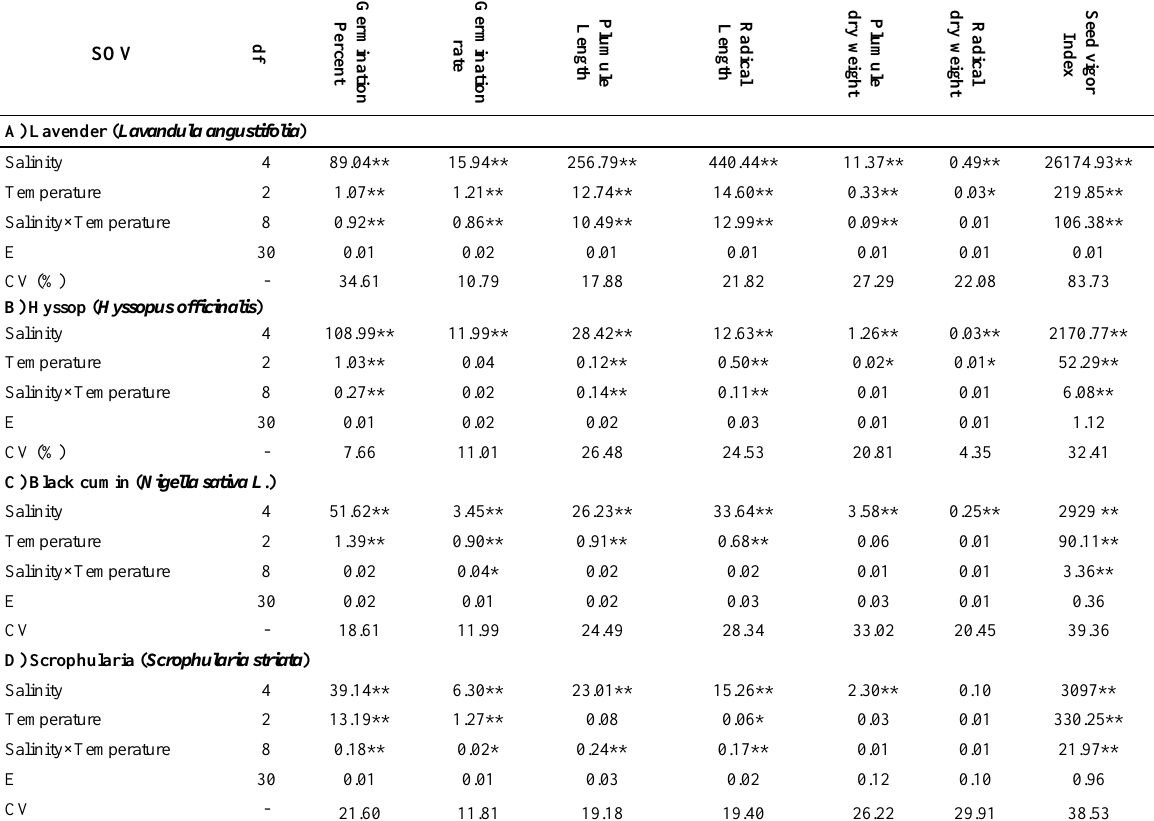
Table 1. Results of analysis of variance of the studied traits under salinity stress and temperature treatment.